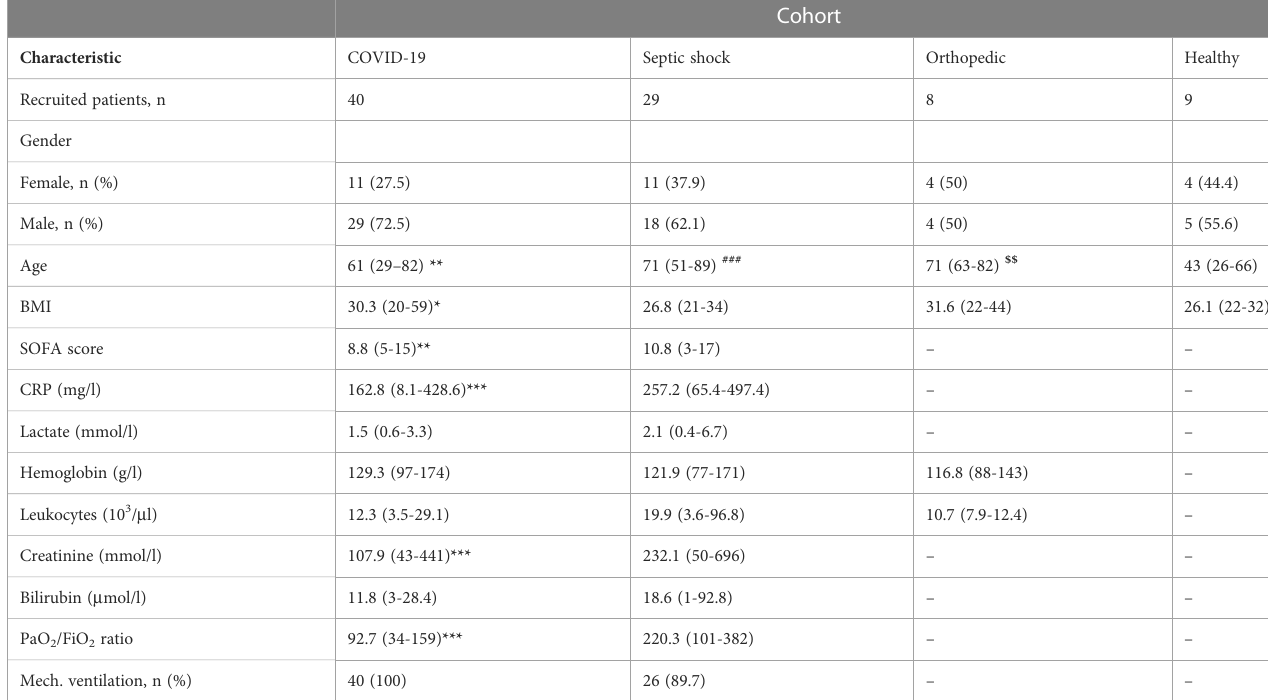
TABLE 1 Demographic and clinical characteristics of each cohort at